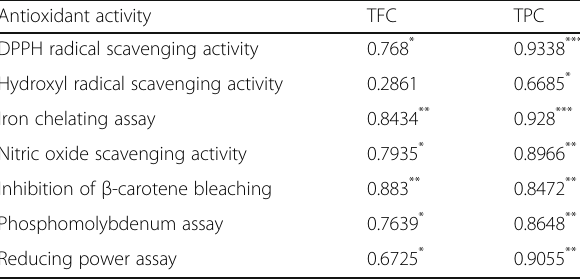
Table 3 Correlation of IC 50 values of different antioxidant activities with total phenolic and total flavonoid